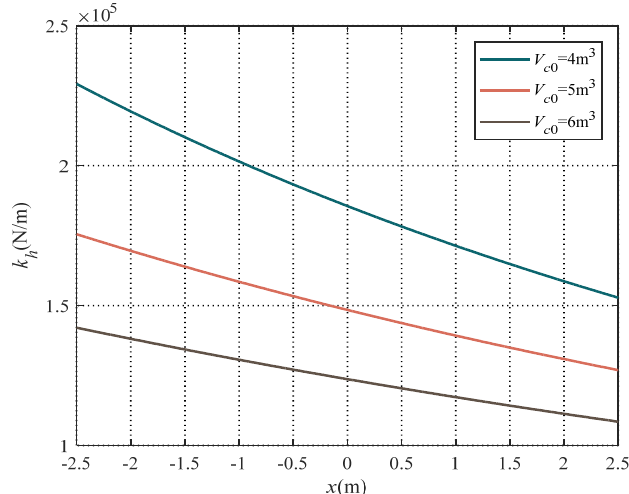
Figure 6. Effect of Gas Volume on Stiffness.